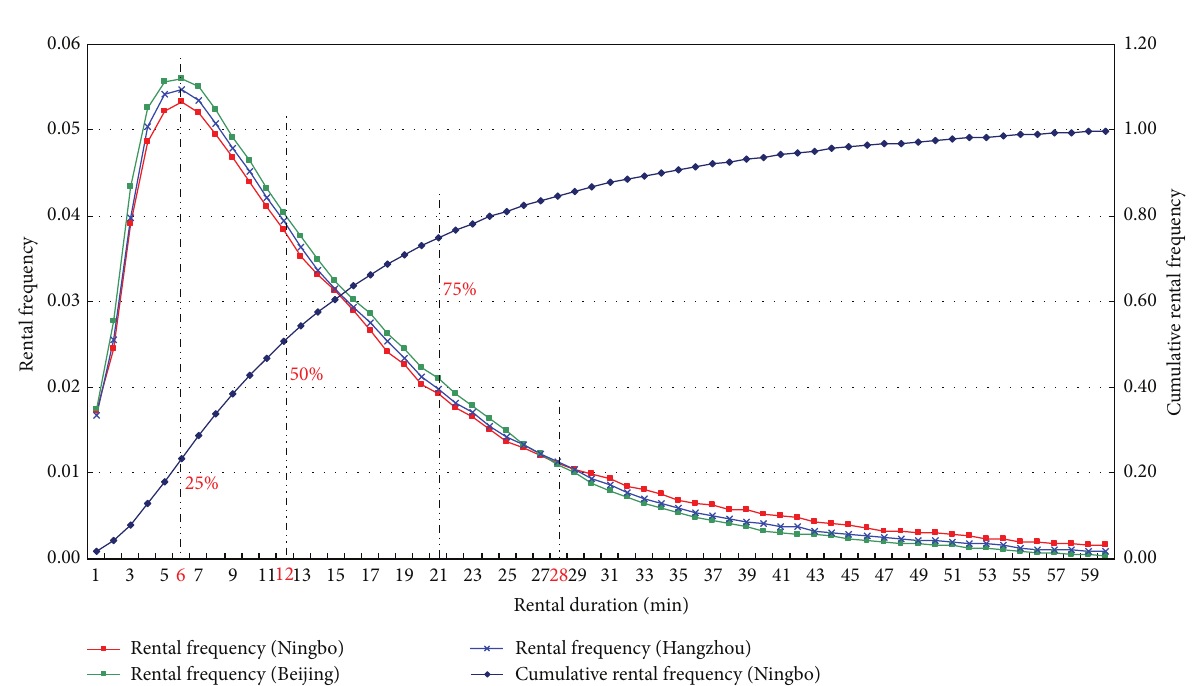
Figure 2: Characteristics of public bicycle rental duration for the three cities.